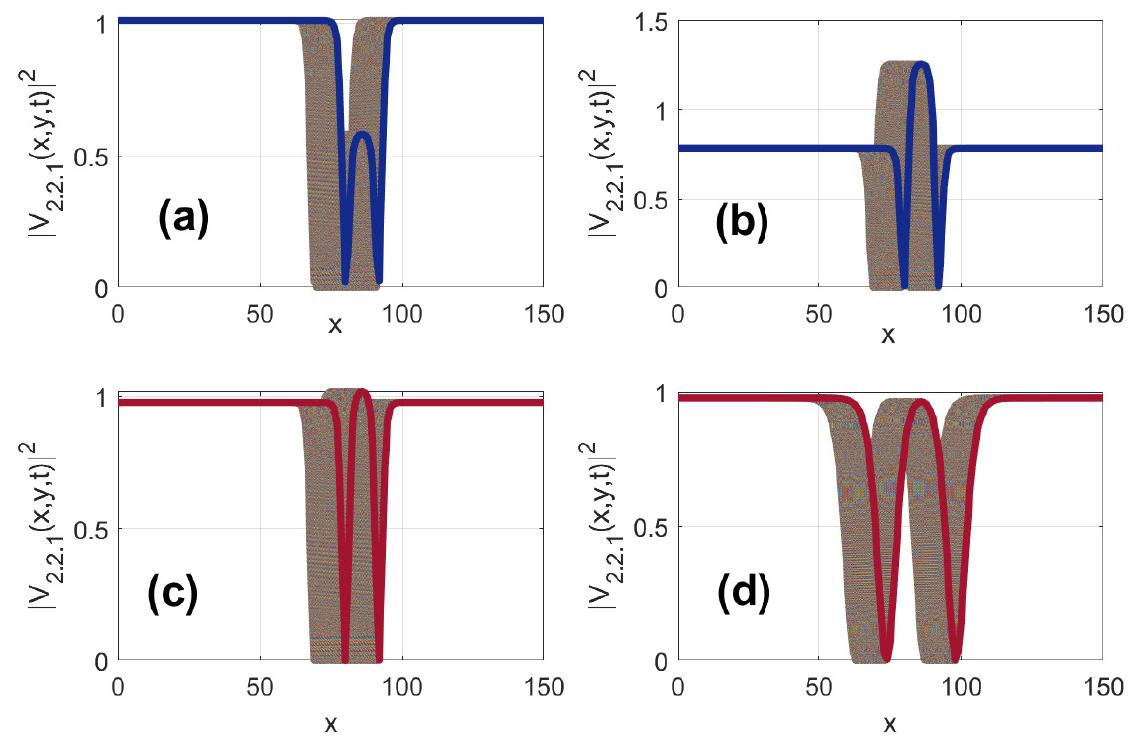
Figure 5. W-SS with variation in the potential parameters α and β . ( a , b ) are, respectively, the values of the parameter α , while ( c , d ) denotes the potential parameter β . ( a ) α = 0.19 V − 1 , ( b ) α = 0.29 V − 1 , ( c ) β = 0.019 V − 1 and ( d ) β = 0.02 V − 1 . The parameters used are p = q = 1, ϑ 0 = 0.1, B 0 = − 0.02, λ 2 = 10.5, λ 4 = −